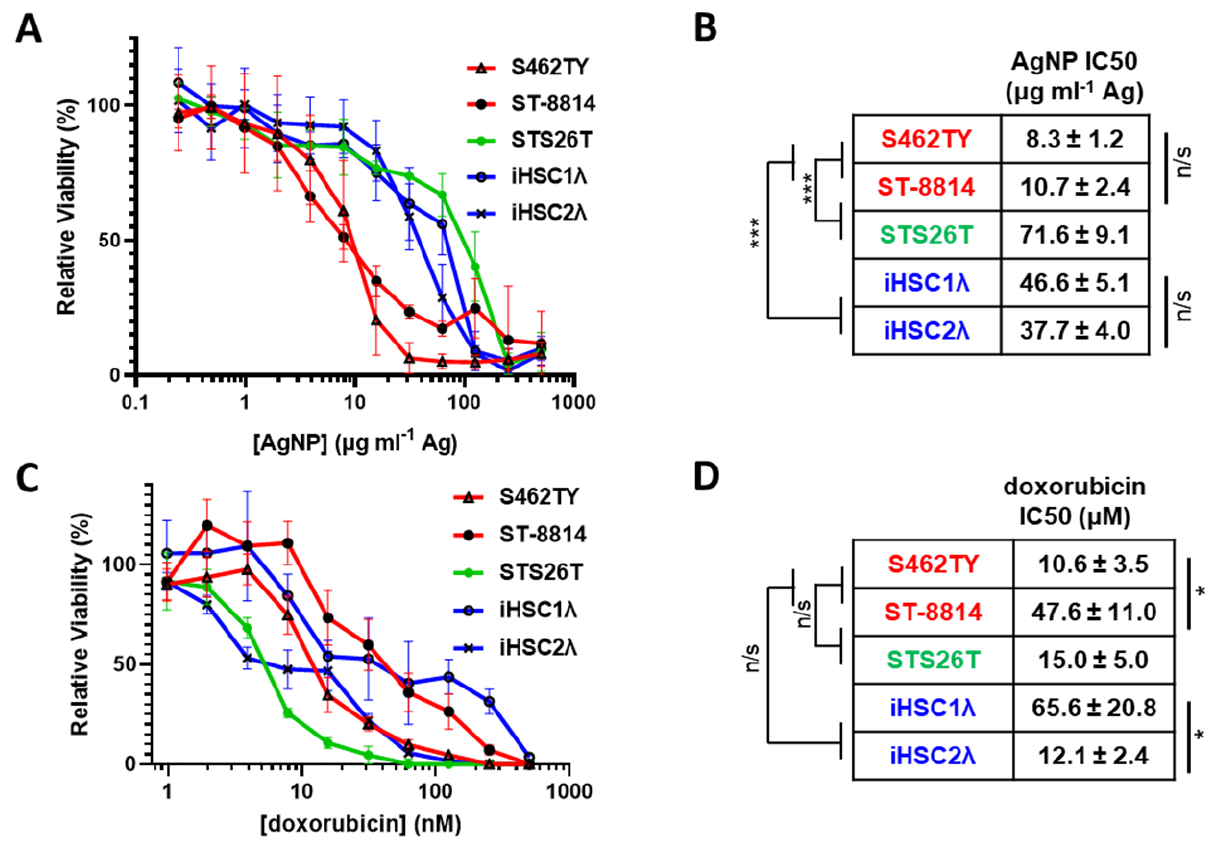
Figure 1. AgNPs show selective cytotoxicity against NF1-null MPNSTs relative to NF1-associated MPNSTs and normal Schwann cells, whereas standard of care doxorubicin does not show selectiv- ity. ( A ) NF1-associated NF1-null MPNSTs (shown in red; S462TY and ST-8814), sporadic NF1-